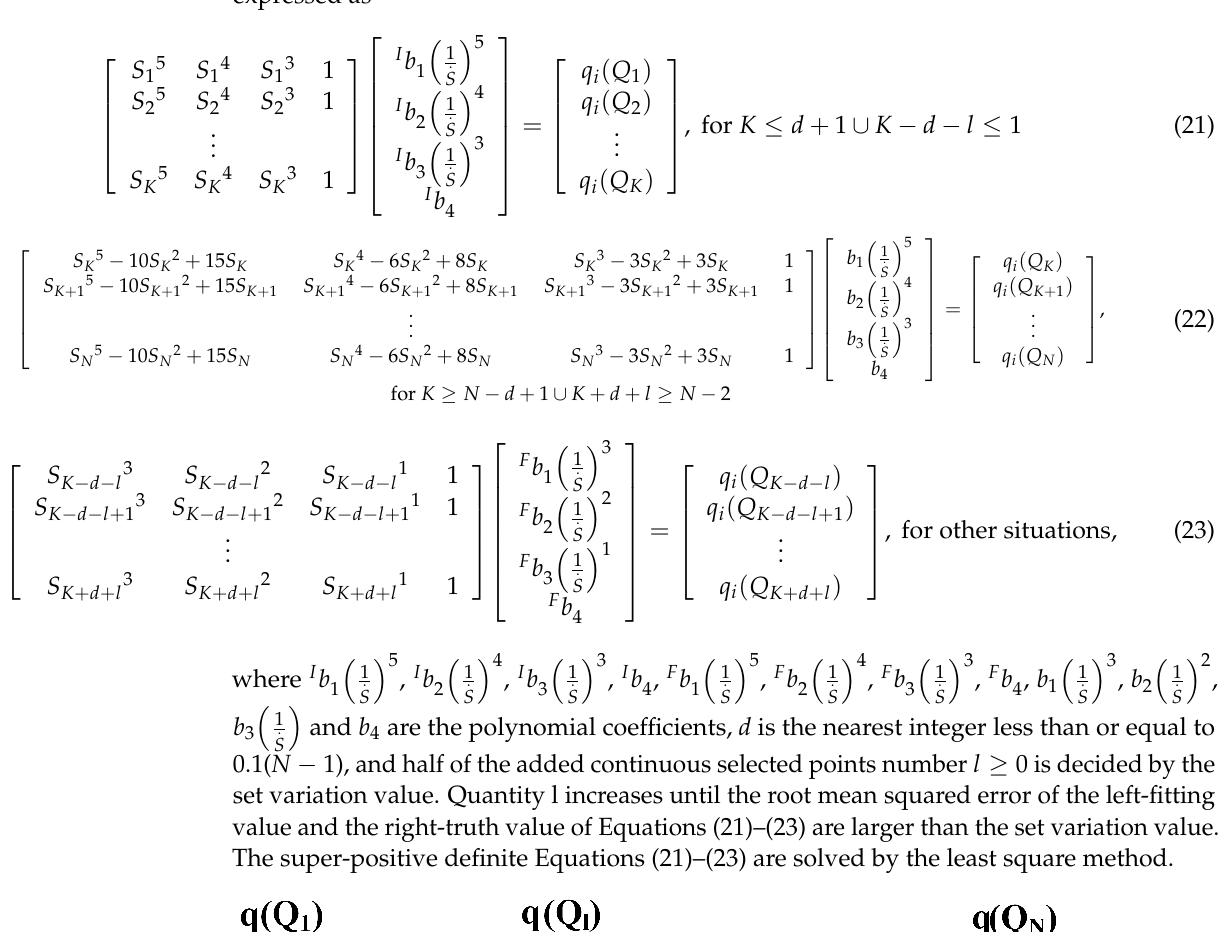
crete optimization objective expression Error! Reference source not found. and con- straints Equation Error! Reference source not found. .